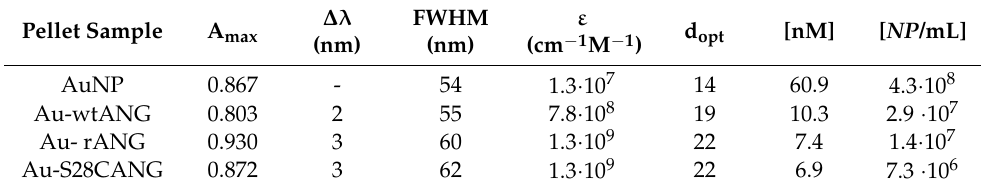
Table 4. UV-visible quantitative analysis of washed AuNP-ANG samples. Experimental values of maximum of absorption (A max ), wavelength shift at the absorbance maximum ( ∆ λ ) and full width at half maximum (FWHM). Calculated values of extinction coefficient ( ε ), optical diameter ( d ) and nanoparticle concentration for the pellets re-suspended in 1 mM MOPS.